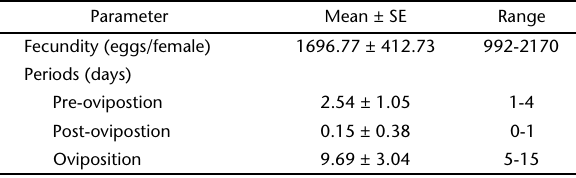
Table II. Mean fecundity and duration of the pre-, post-, and oviposition periods (days) of Agrotis malefida reared